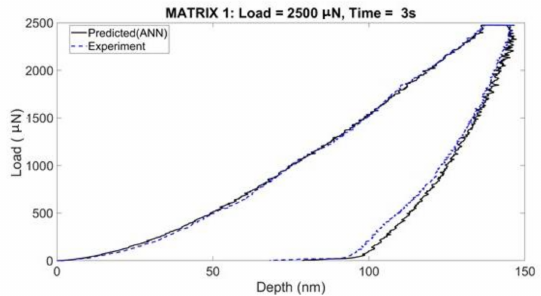
Figure A2. Comparison: experiment vs. predicted for load of 2500 µ N and holding time of 3 s for spark-plasma-sintered hydroxyapatite (SPS-HA) for Matrix-1.